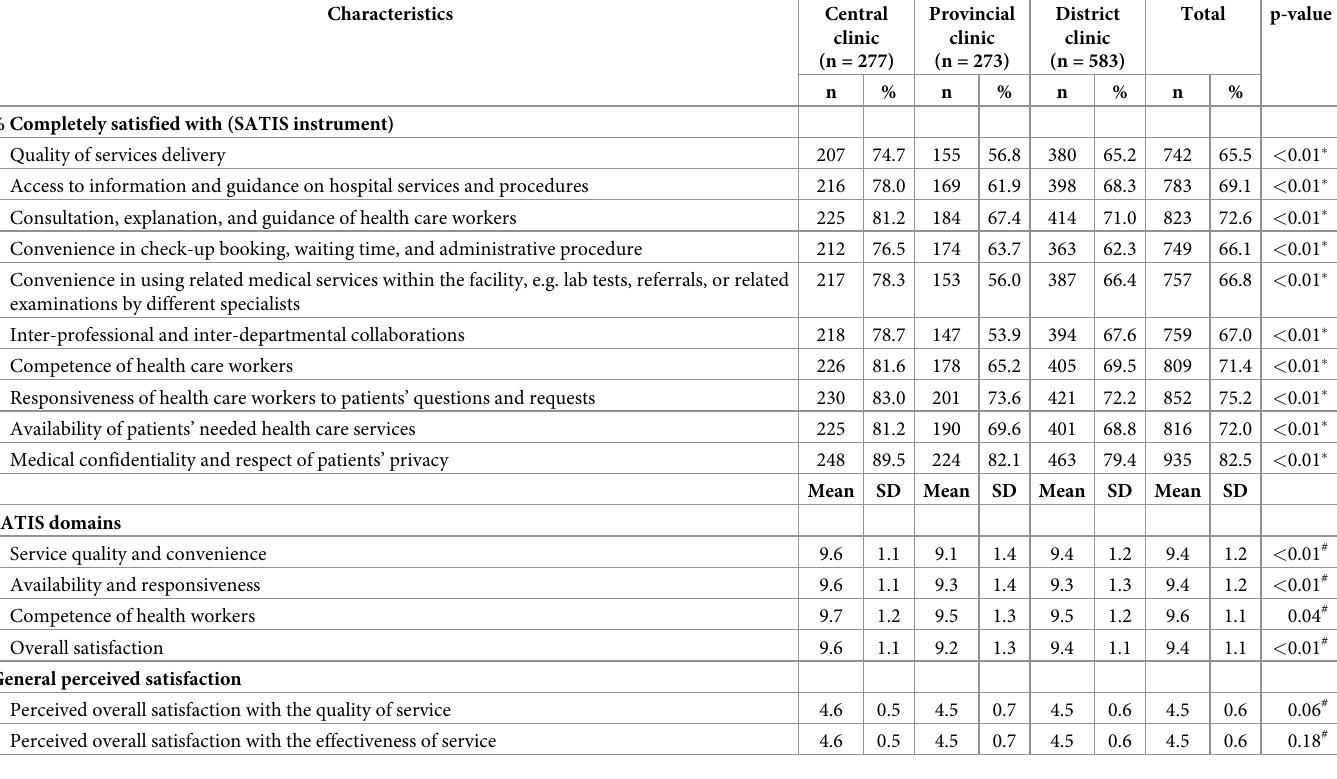
Table 3. Patients’ satisfaction measured by Satisfaction with HIV/AIDS Treatment Interview Scale (SATIS) (n = 1133).